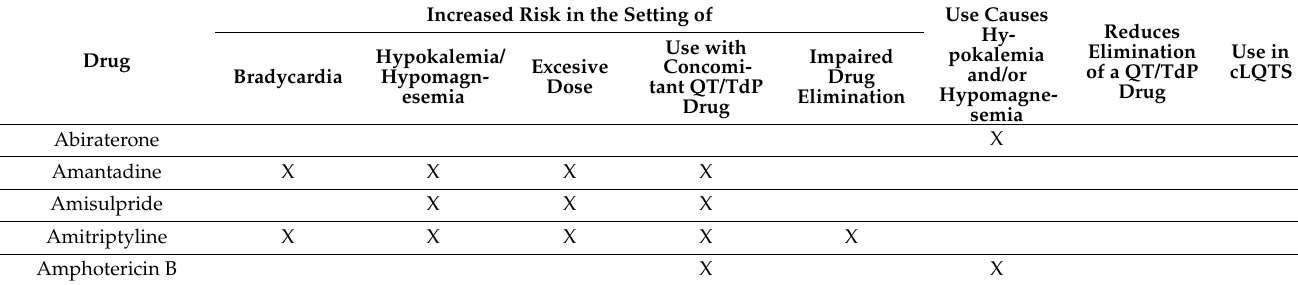
Table 5. CredibleMeds ® list of drugs with a conditional risk for TdP and risk factors.